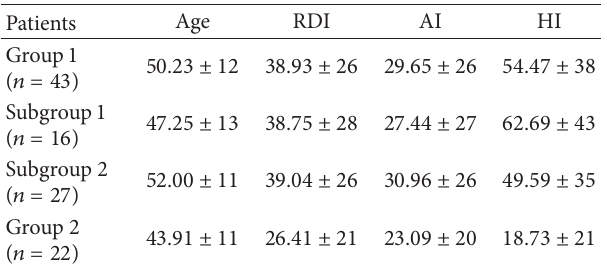
Table 1: Demographic and clinical characteristics in patients with